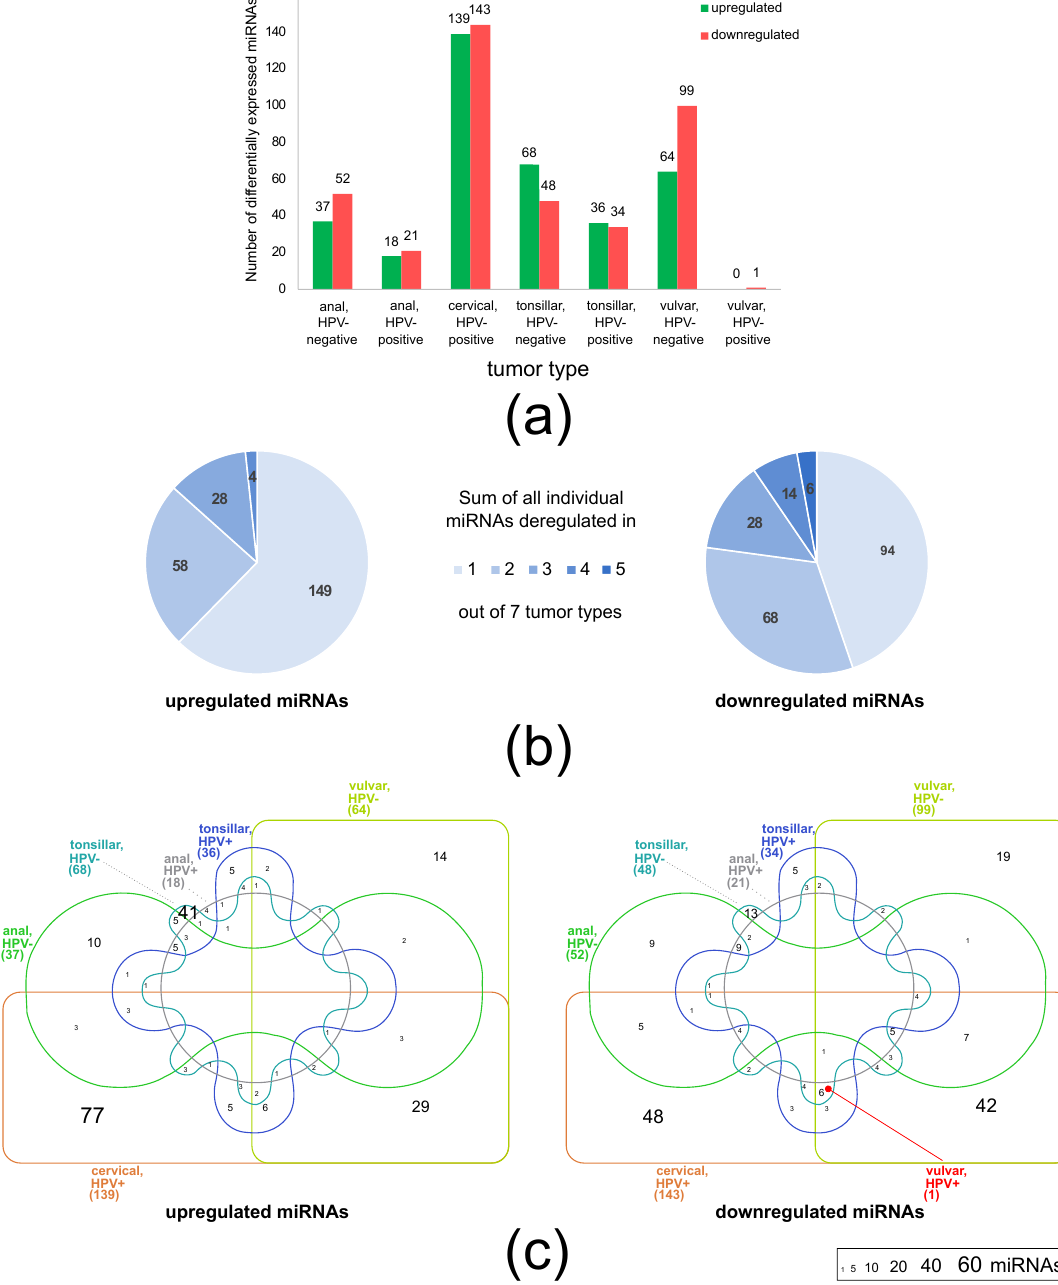
Figure 2. DE of miRNAs in tumors of different locations and HPV status. ( a ) Total numbers of differentially expressed miRNAs in each of the seven analyzed tumor types. ( b ) The miRNAs that exhibited shared deregulation across the seven studied tumor types. The values denote the total numbers of miRNAs which were deregulated specifically in one tumor type and those whose deregulation was common to two, three, four, or five tumor types. No miRNAs were deregulated in more than five tumor types. ( c ) Venn diagrams depicting the numbers of unique and shared differentially expressed miRNAs among the seven studied tumor types. The font size range is denoted in the legend. Zero values were omitted. The placement of the sole miRNA deregulated in HPV-positive vulvar tumors (MIR451A) is marked with a red dot. DE values were calculated with respect to normal tissues and filtered (FC ≥ 2.0, p adj ≤ 0.1; see Materials and Methods). For DE values of individual miRNAs, see Table S3. Venn diagrams were created using InteractiVenn